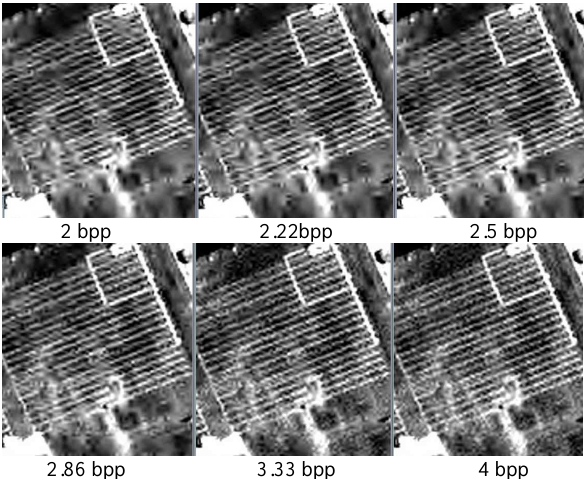
Figure 8 Compression artefacts in panchromatic images Fig 8 point out the compression blurring effect on high frequency details for bit rate values less than 2.86 .